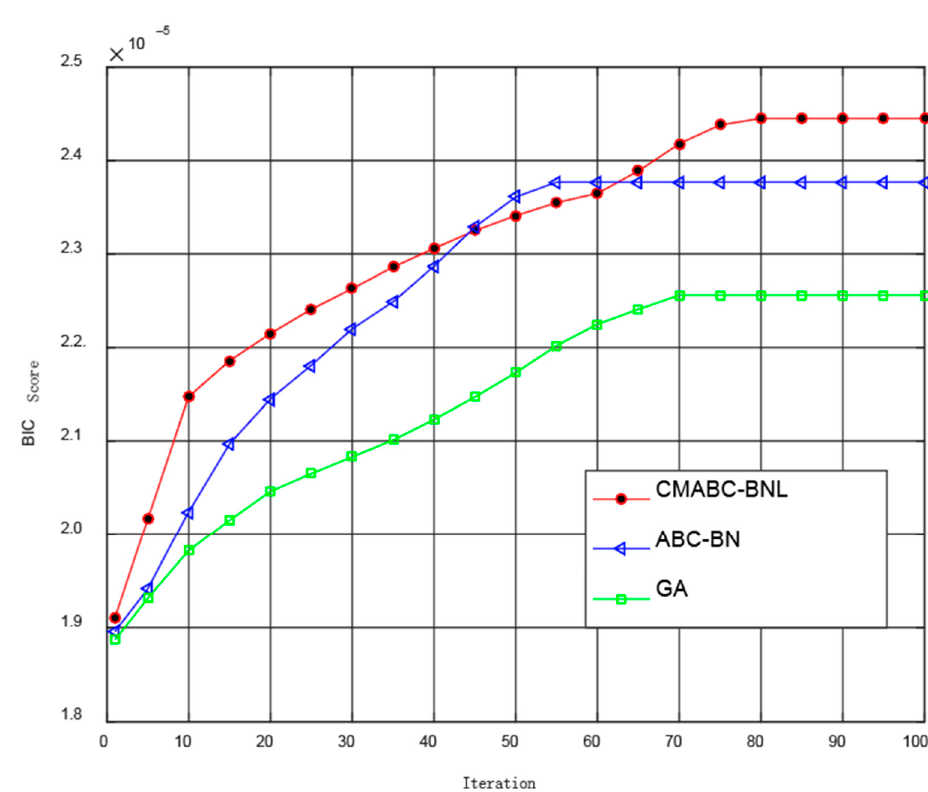
Figure 9. ALARM experiment results under 5000 data sets.